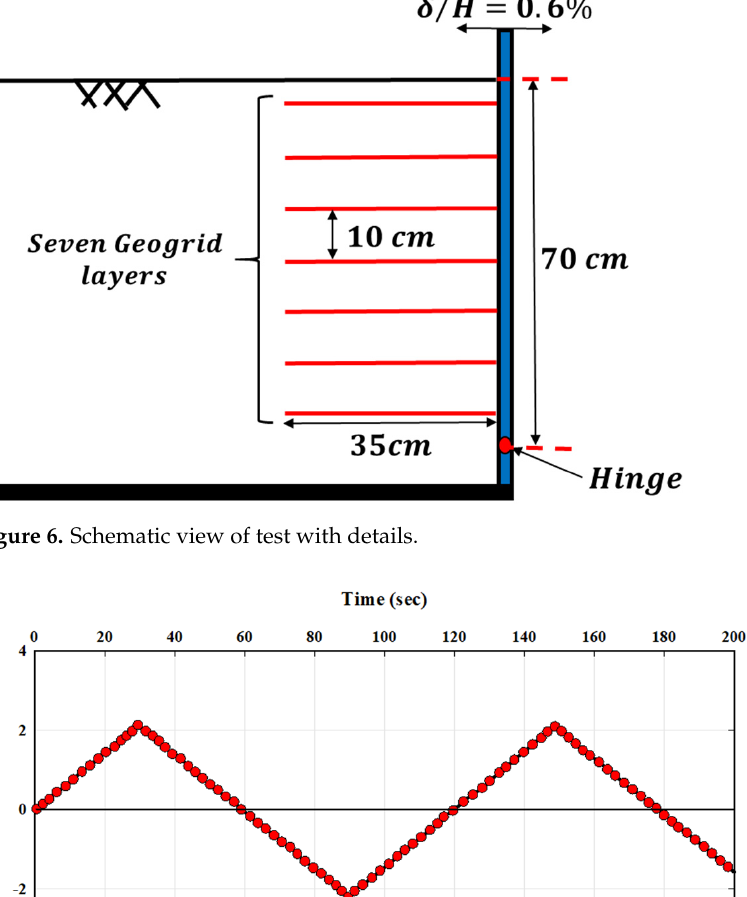
Figure 8. Pluviation and geogrid connection to the wall. In order to detect possible slip lines and measure vertical settlement in the backfill soil, layers of thin horizontal black sand are used adjacent to the glass wall in 10 cm intervals. The settlements behind the wall are measured by using a mesh drawn on the sidewall from photographic images. Lateral Soil Pressure Coefficients The lateral soil coefficient is the horizontal and vertical pressure ratio on a soil element in its natural state or behind retaining walls. In geotechnical engineering, there are three well-defined lateral soil coefficients behind a retaining wall: passive, active, and at rest. These coefficients are used in problems based on the relative movement of the wall and backfill soil. The at-rest coefficient is used when there is no relative movement between the wall and backfill. The passive and active coefficients are used when the wall moves toward or backward from the backfill. These two values can be obtained from limit analysis based on the large wall movements and are theoretically the upper and lower bound of the lateral earth pressure. The abutment movements of an integral bridge toward and backward from the backfill are not large enough to be considered upper or lower bounds. However, the cyclic nature of movements followed by a phenomenon called the